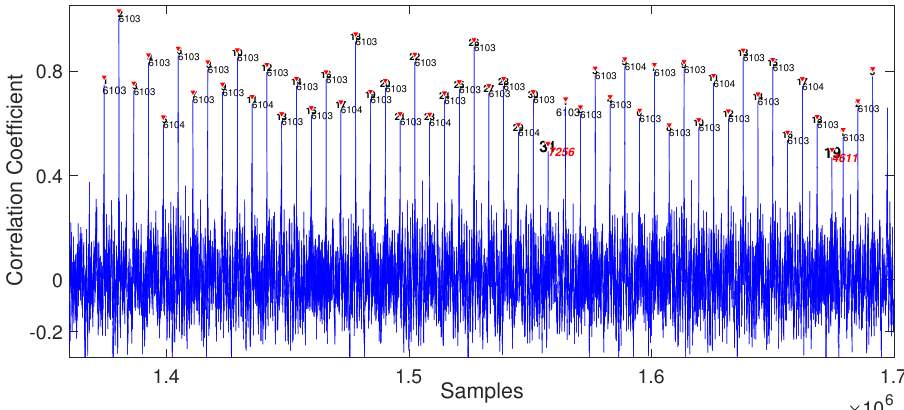
Figure 1. Result: High peaks of the addition and a distance value between the peaks.